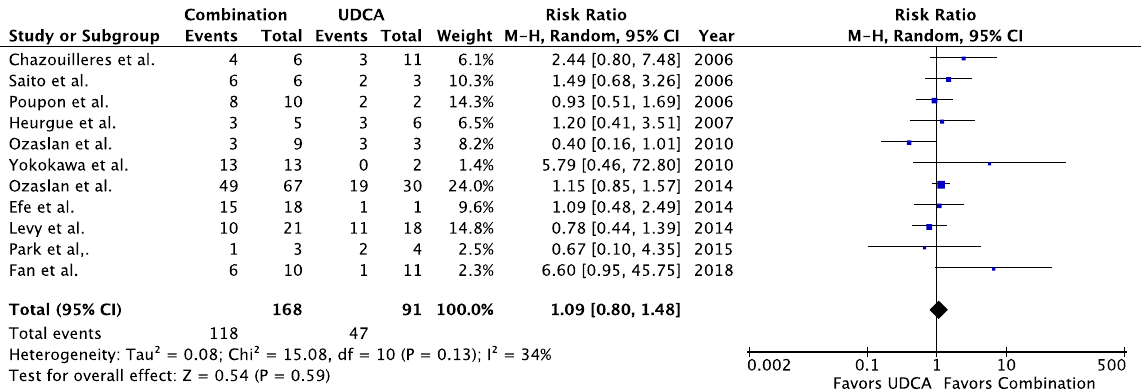
Figure A4. Biochemical improvement in AIH-PBC patients treated with combination therapy vs. UDCA alone, including only those studies in which biochemical improvement was defined by both hepatocellular and cholestatic markers. UDCA = ursodeoxycholic acid, Combination = UDCA + [corticosteroids and/or antimetabolites].